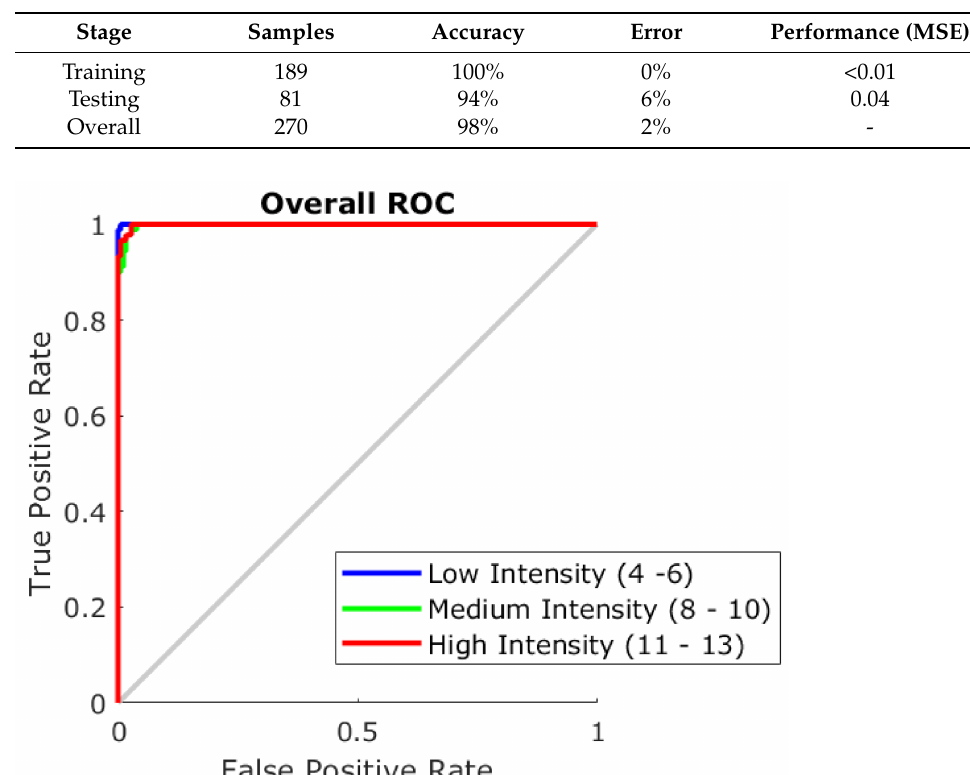
Table 4. Results from the artificial neural network pattern recognition model (Model 1) to clas- sify coffee samples according to the intensity level, showing the accuracy and error of each stage. Performance was assessed based on mean squared error (MSE).